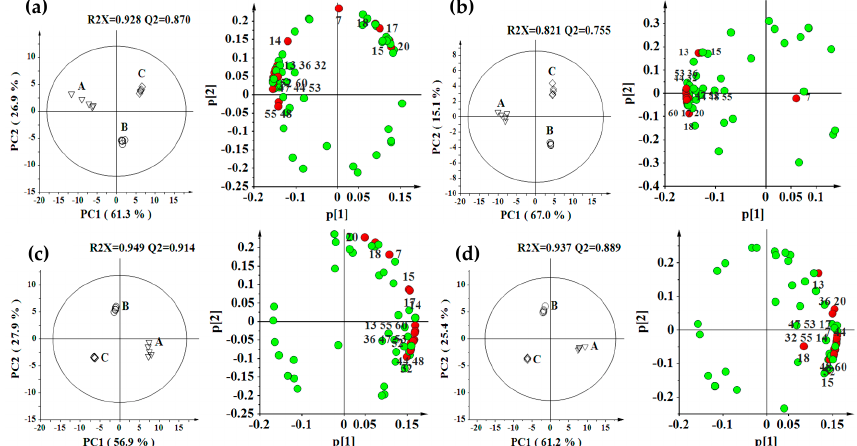
Figure 1. PCA scores plots and loading plot derived from LC-MS data for S. miltiorrhiza extracts from three different locations (A, Zhuyang; B, Changqing; C, Taian) for each genotype (( a ) Genotype 1; ( b ) Genotype 2; ( c ) Genotype 3; and ( d ) Genotype 4). Sixteen red colored metabolites in loading plot were the location-specific metabolites that we obtained from OPLS-DA: 7, Salvianolic acid F; 13, Salvianolic acid І ; 14, Salvianolic acid E; 15, Rosmarinic acid; 17, Lithospermic acid; 18, Prolithospermic acid derivative; 20, Salvianolic acid B; 32, Tanshinone ІІ B; 36, Trijuganone C; 44, 15,16 ′ -dihydrotanshinone І ; 47, Methyltanshinonate; 48, Trijuganone B; 52, Cryptotanshinone; 53, Tanshinone І ; 55, 1,2 ′ -dihydrotanshinone І ; and 60, Tanshinone ІІ A.